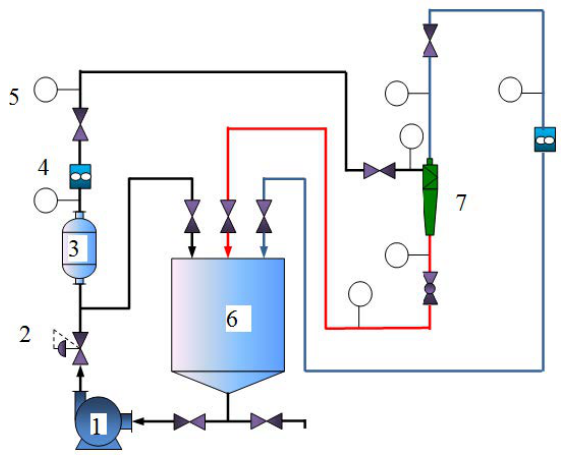
Figure 4. Separation procedure of experimental equipment. 1. centrifugal pump 2. equalizer valve bumper tank 4. flow meter 5. gauge meter 6. feed tank 7.